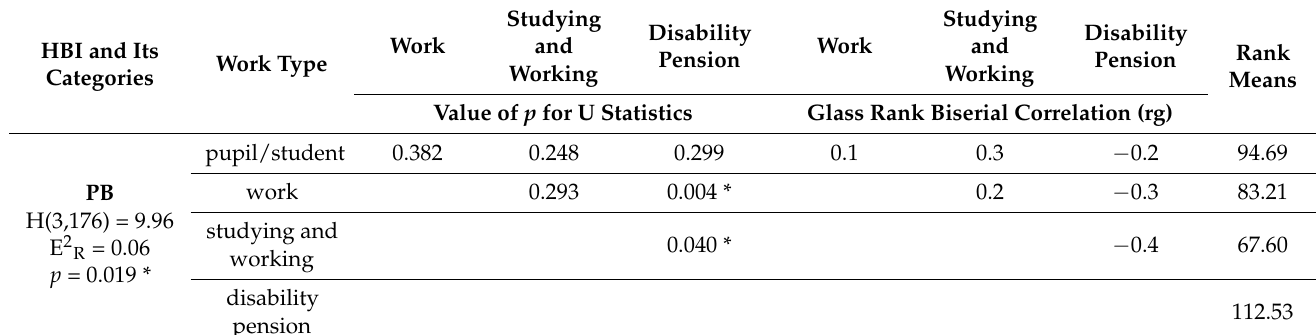
Table 6. Health behaviors of people practicing wheelchair basketball, wheelchair rugby and para- rowing depending on the work performed (the U test,